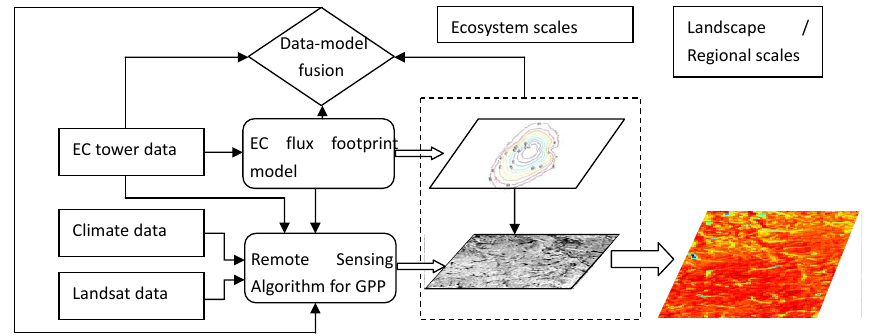
Fig. 1. Flow diagram of the GPP upscaling algorithm based on LANDSAT and EC tower